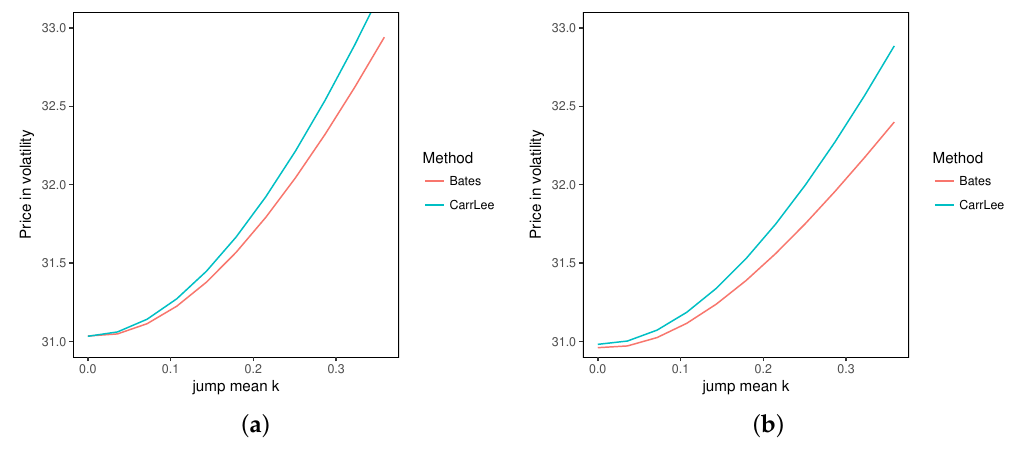
The jump mean is of opposite sign in the parameter set from Schoutens et al. (2003), and now, the continuous replication overestimates the price of the variance swap (Figure 2a).